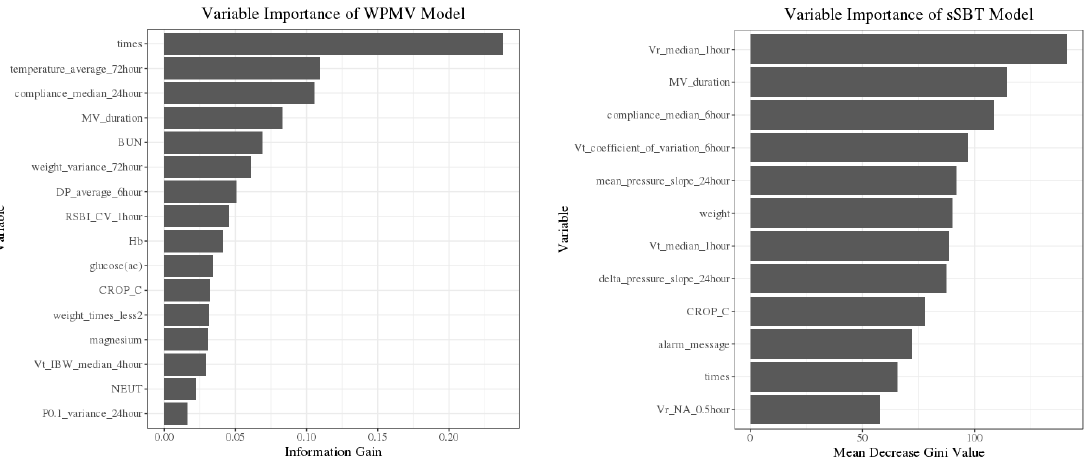
Figure 3. Importance ranking of predictors in WPMV and sSBT model. (WPMV: weaning proba- bility of mandatory ventilation. sSBT: successful spontaneous breathing trial. times: number of ventilator mode shifting. MV: mechanical ventilator; BUN: blood urea nitrogen. DP: diastolic pressure. RSBI: rapid-shallow breathing index. CROP: Compliance, Respiratory Rate, Oxygenation, and Pressure index. Vt: tidal volume. IBW: ideal body weight. Vr: ventilation rate.)